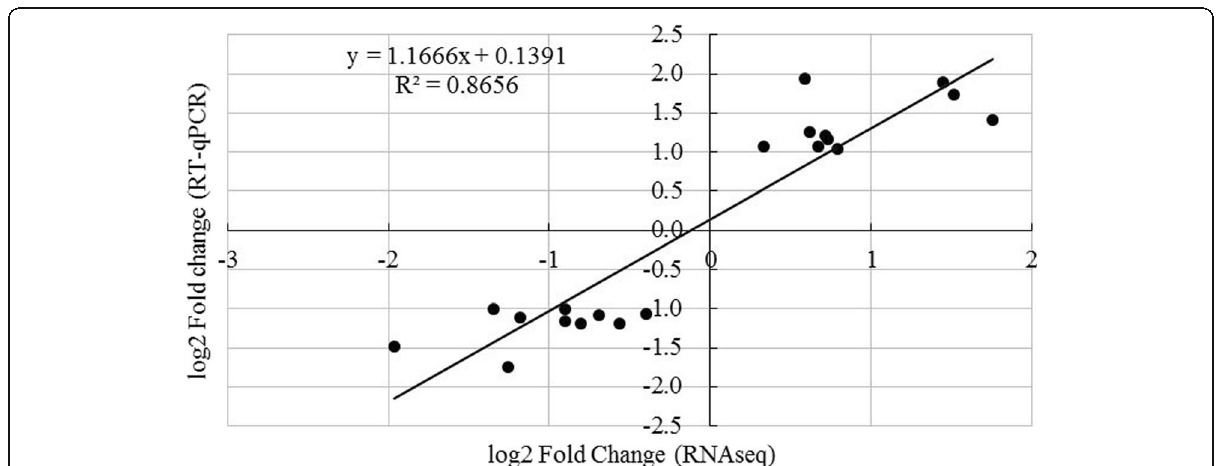
Fig. 5 Comparison of the log2-value of fold-change (log2FC) of 10 selected transcripts determined using RNA-Seq and